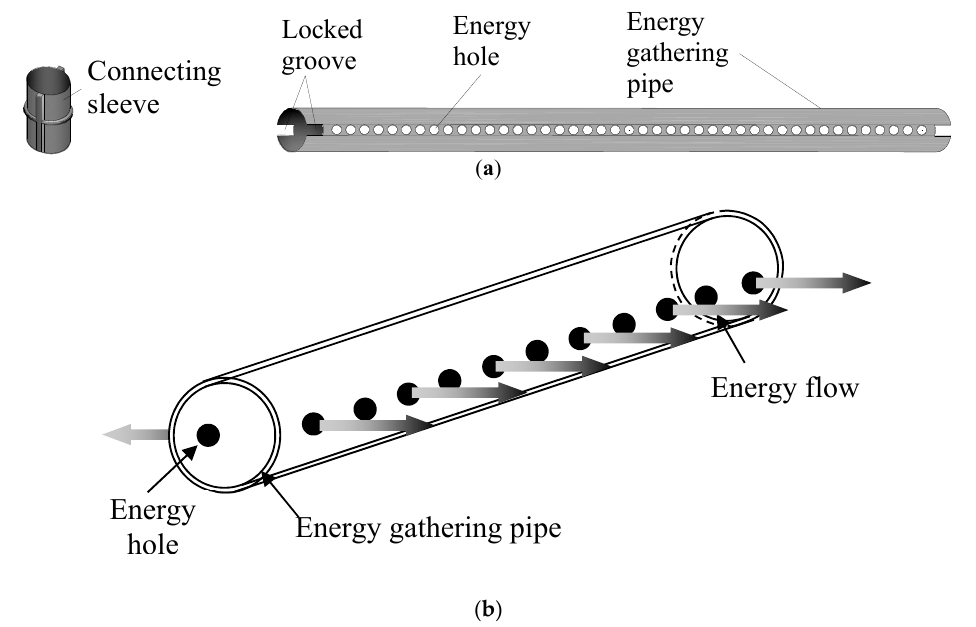
Figure 3. Device and principle of bidirectional concentrated tension blasting (BCTB): ( a ) structure of connecting sleeve and energy gathering pipe; ( b ) blasting control mechanism.